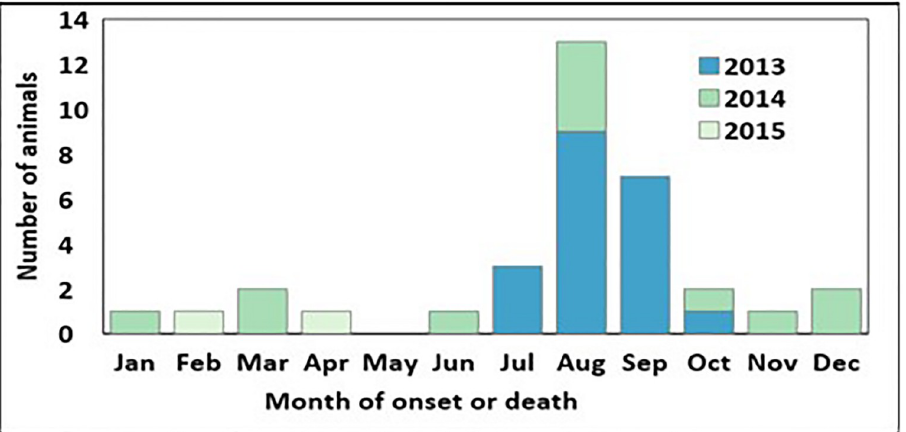
Fig 1. Case distribution during the two-year study period (1 June 2013–31 May 2015) by month and year of